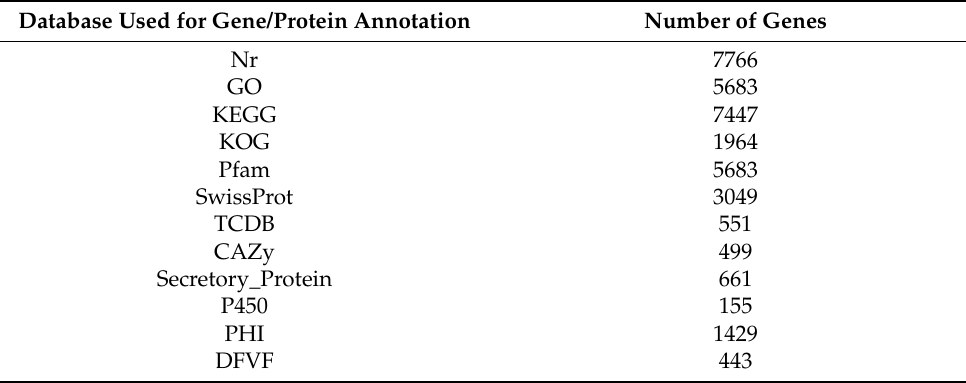
Table 3. Number of genes annotated in each database for the coding